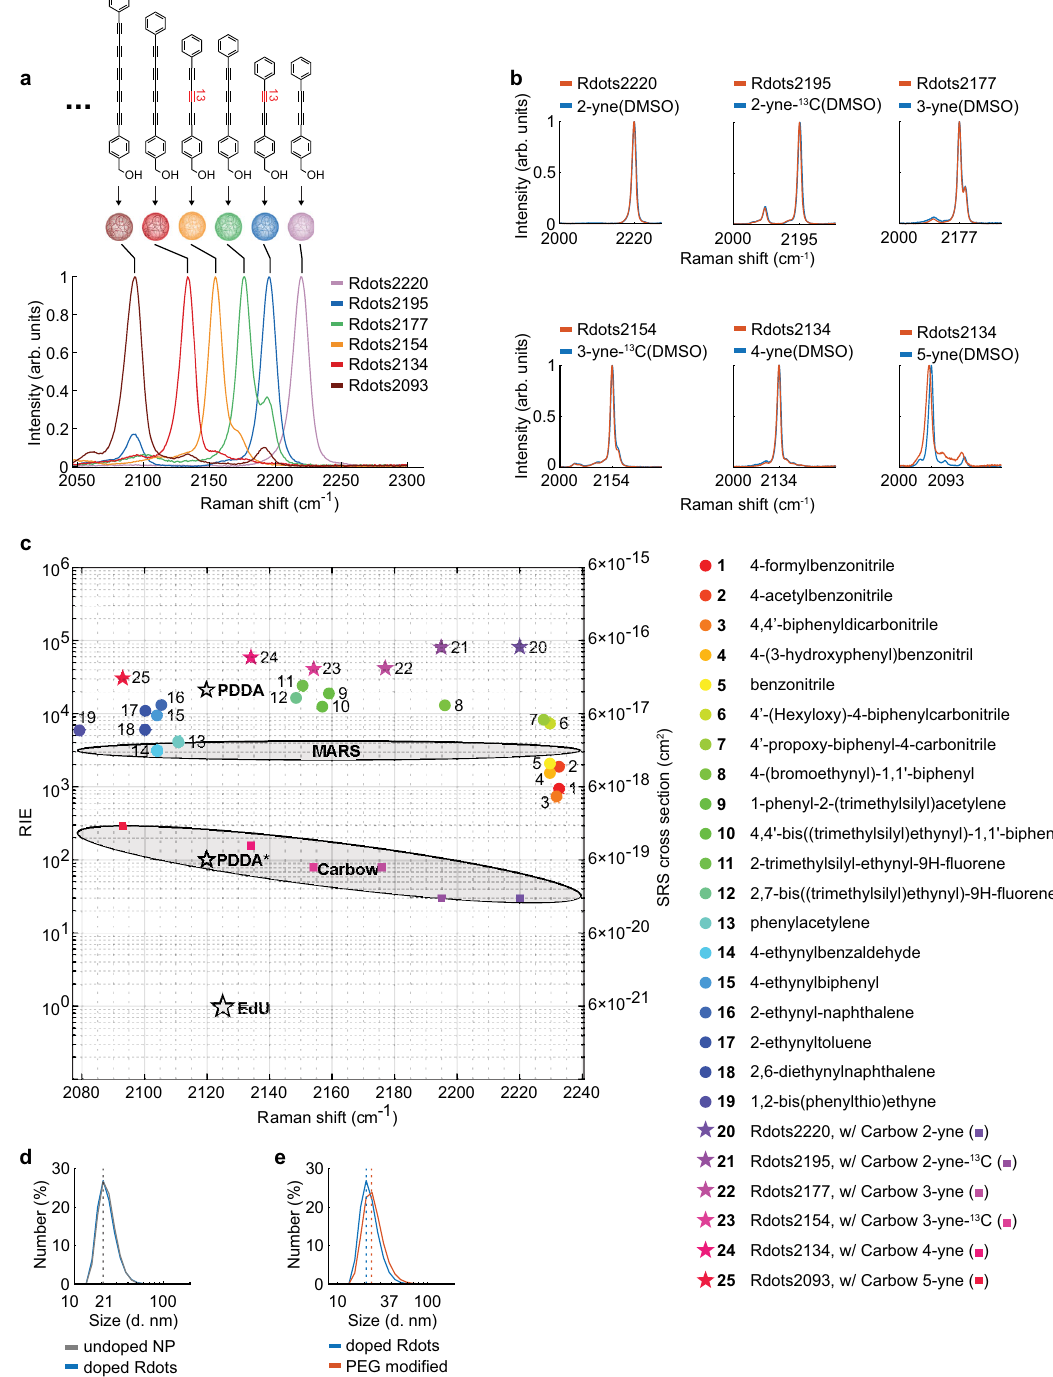
Fig. 2 Characterizations of Rdots. a Spontaneous Raman spectra of six Rdots generated using Carbow dyes. arb. units: arbitrary units. b Raman spectra of Rdots and free Carbow dyes in DMSO, showing no signi fi cant peak shift or broadening. arb. units: arbitrary units. c RIE and Raman shift of Rdots made by various alkyne and nitrile containing probes. Rdots were made with a large variety of compounds that contain alkyne or nitrile molecules, and their RIE (relative Raman intensity versus EdU) values and Raman shifts were measured. RIE values were measured with Spontaneous Raman spectrometer with 532 nm excitation wavelength, except MARS dye, which were evaluated with SRS microscopy. Probes indicated with colored stars were used for immunostaining in this study. PDDA: poly(deca-4,6-diynedioic acid) 20 , EdU: 5-ethynyl-2 ’ -deoxyuridine. d Hydrodynamic diameter of PS nanoparticles before and after doping measured by DLS. The size distributions show no change when PS nanoparticles are doped with Raman dyes, and the resulting 21 nm Rdots are monodispersive. e Hydrodynamic diameter of Rdots after